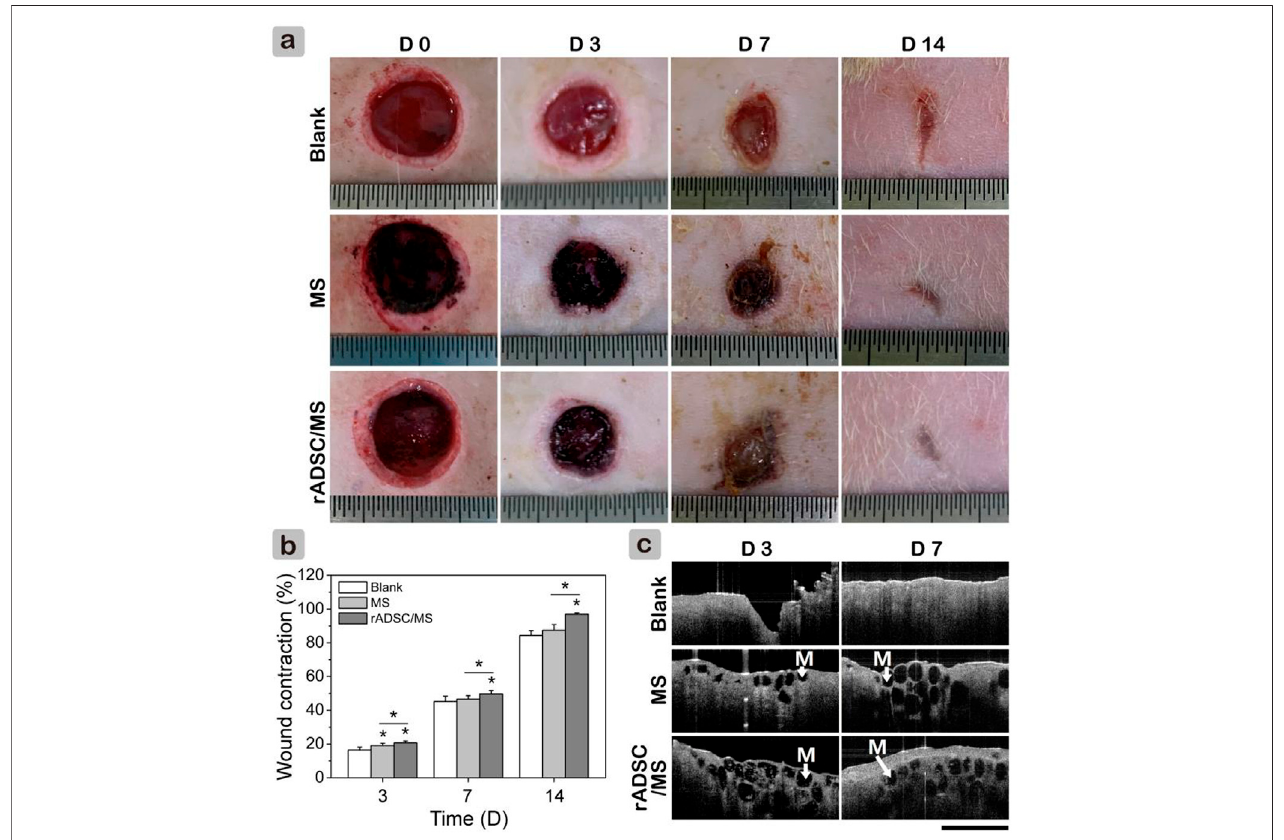
FIGURE 3 | Effects of gelatin microspheres on wound healing in diabetic rats. (A) Wound healing process within 14 days was recorded in photographs. Length betweenadjacentlinesonruleris0.5 mm. (B) Woundcontractionwascalculatedbasedontheseimages(data=mean±SD, n =5,* p < 0.05). (C) OCTscanningimages for section view of regenerate granulation tissue. Black circles (also “ M ” ) in wound area represent gelatin microspheres. Scale bar is 2 mm.